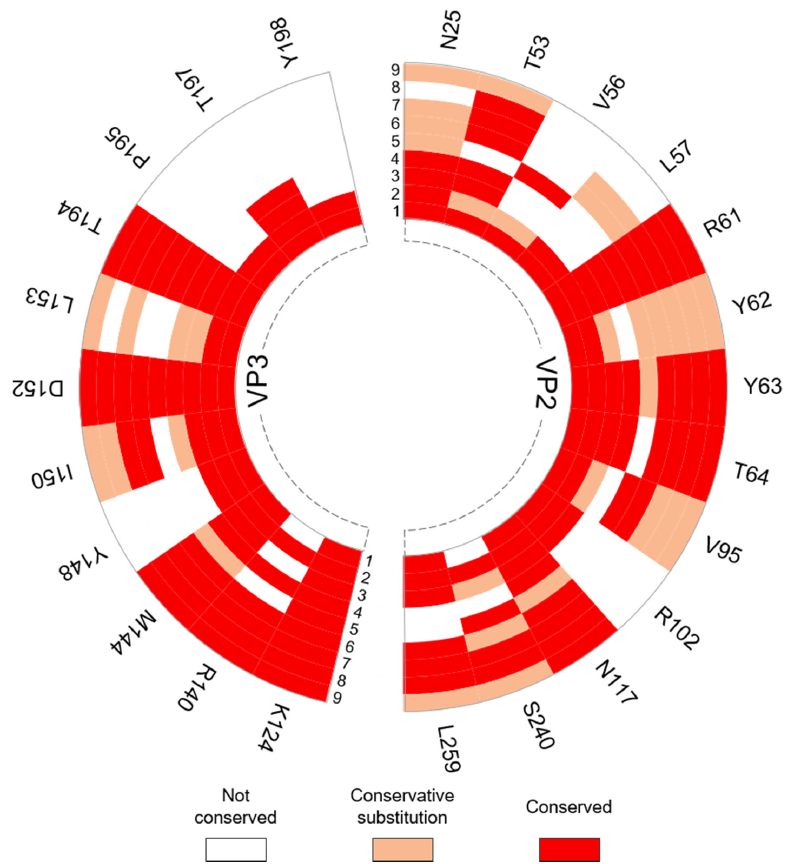
Figure 8. Radial map of the conservation of TMEV interpentamer residues identified as hotspots across respective picornavirus species. The individual TMEV capsid proteins were submitted to ENDScript2 for conservation analysis. The degree of conservation for each TMEV hotspot was nine representative picornaviruses across four genera. Identity of viruses: 1) Cardiovirus B